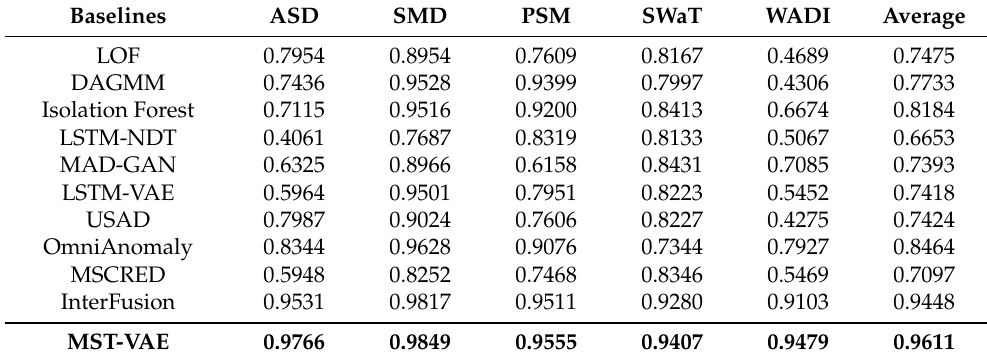
Table 3. Performance comparison of the best F1 Scores of different baseline methods on five datasets.